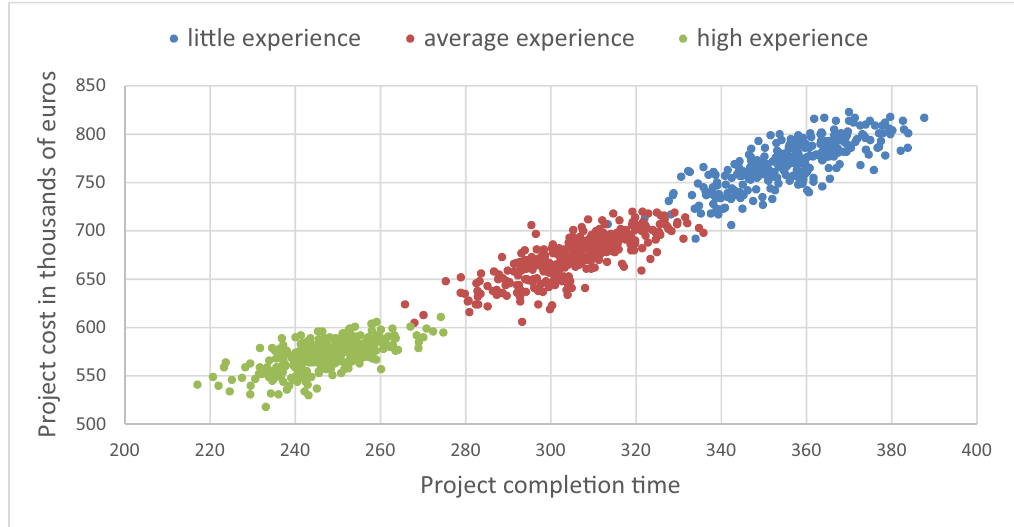
Figure 9: Cost – time dependency for a designer with a normal risk approach and a site manager with a normal risk approach, divided by worker experience rating.